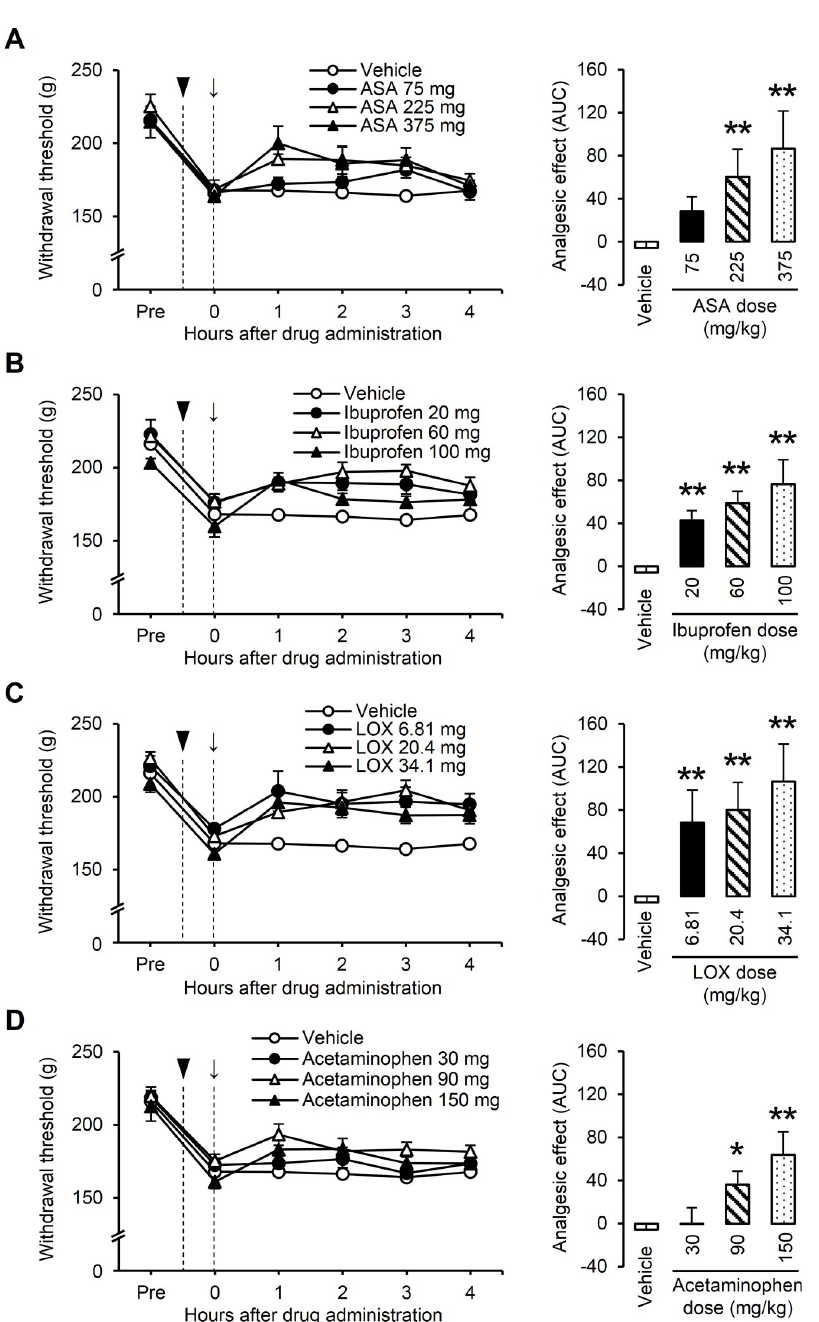
Fig 3. Dose-dependent analgesic effects of NSAIDs and acetaminophen on muscular mechanical hyperalgesia when developed by lengthening contractions (LC). Effect of (A) acetylsalicylic acid (ASA 75, 225, or 375 mg/kg), (B) ibuprofen (20, 60, or 100 mg/kg), (C) loxoprofen sodium (LOX 6.8, 20.4, or 34.1 mg/kg) and (D) acetaminophen (30, 90, or 150 mg/kg). All drugs were administered orally. Arrow and arrowhead indicate time point of drug administration and LC, respectively. Baseline withdrawal thresholds (Pre) were measured 1 day before LC and drugs were administered 24 h after LC. Graphs on the right side show the magnitude of analgesia with an index of the area under the time course curves (AUC) of the withdrawal thresholds. ASA, ibuprofen, LOX, and acetaminophen dose- dependently increased AUC (n = 6 rats for each concentration of the drugs, and n = 36 rats pooled in the vehicle group so that the larger sample size was obtained, � P < 0.05 and �� P < 0.01, vs. vehicle, one-way ANOVA followed by Dunnett’s post-hoc test). Data of the vehicle group is identical for Fig 3A–3D.